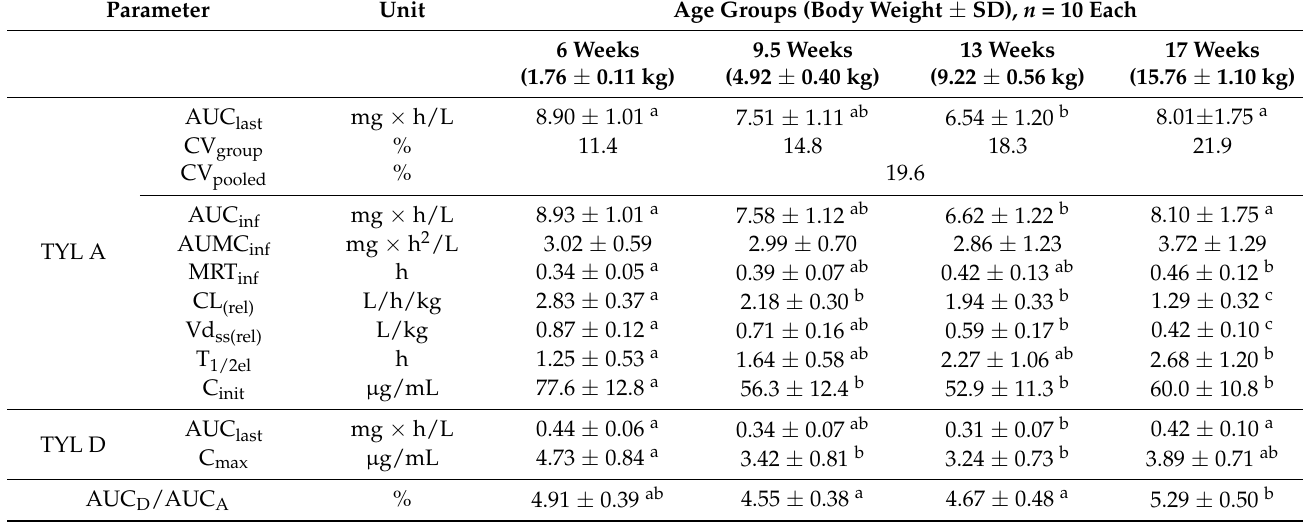
Table 1. Pharmacokinetic parameters after single intravenous tylosin tartrate administration to turkeys dosed according to the protocol: Dose = 31.6 × BW 0.58 .